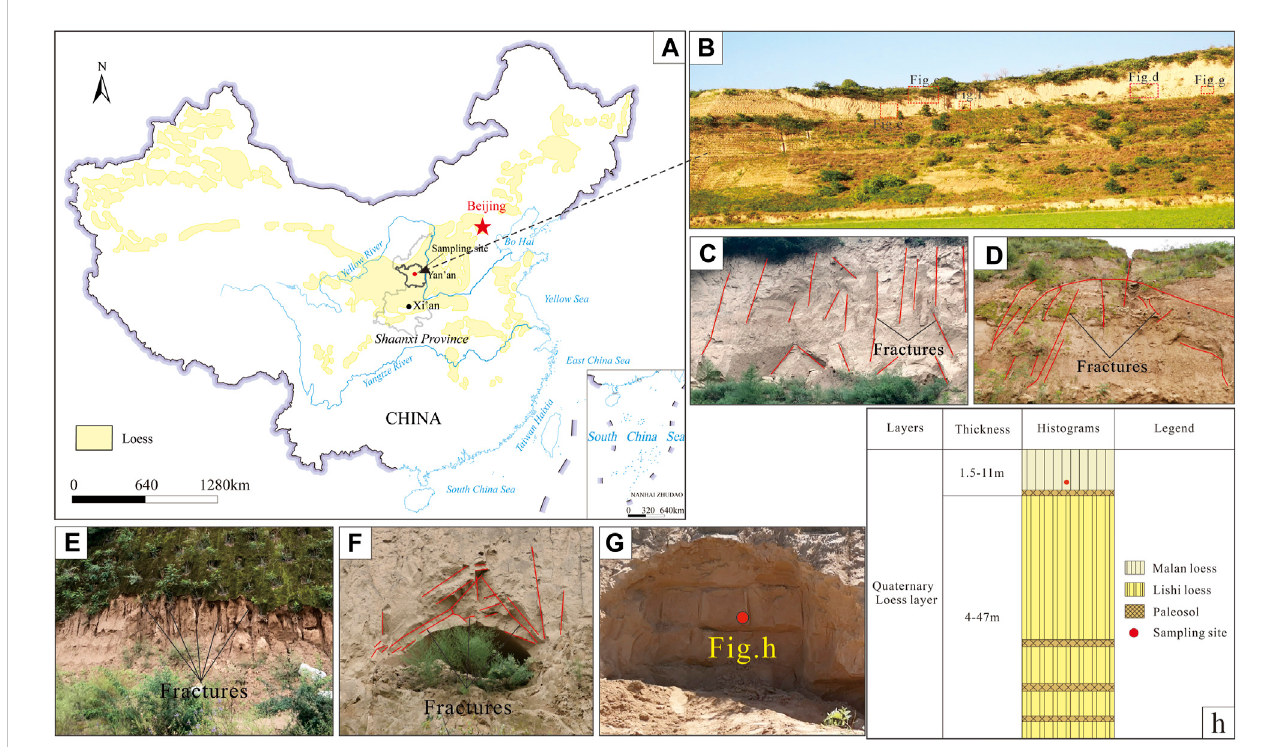
FIGURE 1 Location map: (A) distribution of loess in China and location of the study area in Yan ’ an city, China; (B) wide view of study side slope; (C – F) are close-up view of side slop fracture generated by different factors: (C) biological effect; (D) rainfall; (E) tectonic joint; (F) human activity; (G) a photograph of loess samples at the sampling site; (H) soil pro fi le at the sampling site.